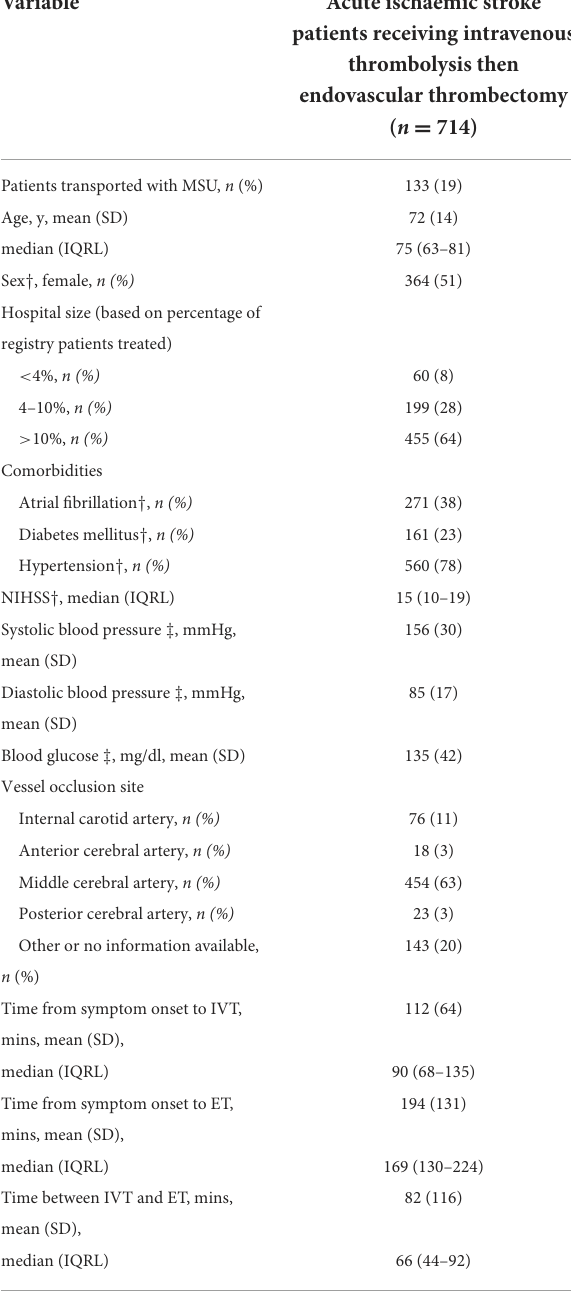
TABLE 1 Baseline clinical and treatment characteristics of patients at hospital